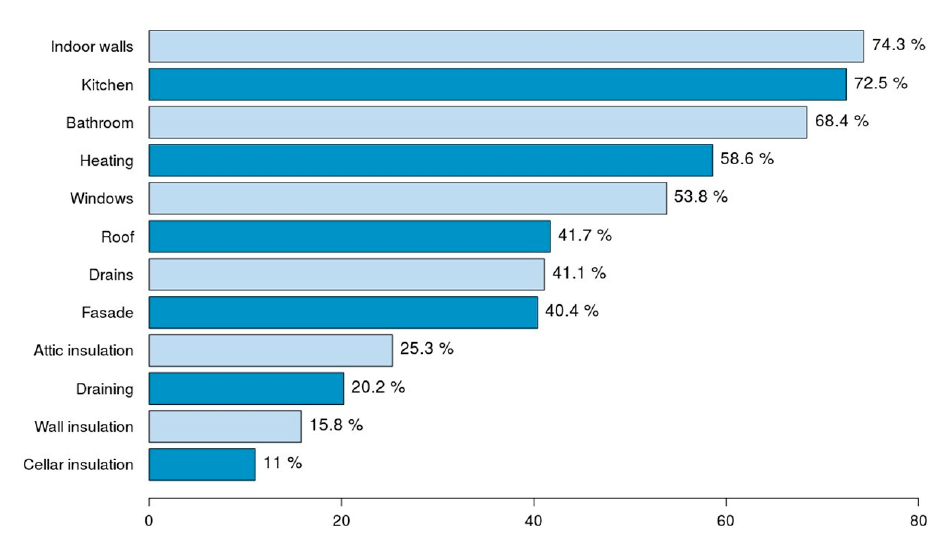
Figure 5. Path coefficients for the physical vs. aesthetic renovation model (significant paths only).